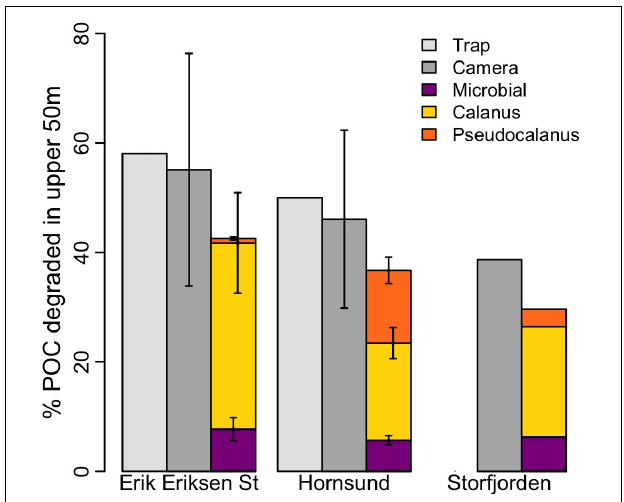
FIGURE 4 | POC degradation in the upper 50 m estimated based on measurements from drifting sediment traps (light gray), from camera profiles (dark gray), calculated microbial degradation based on a C-specific degradation of 0.03 d − 1 (magenta), and calculated Calanus (yellow) and Pseudocalanus degradation